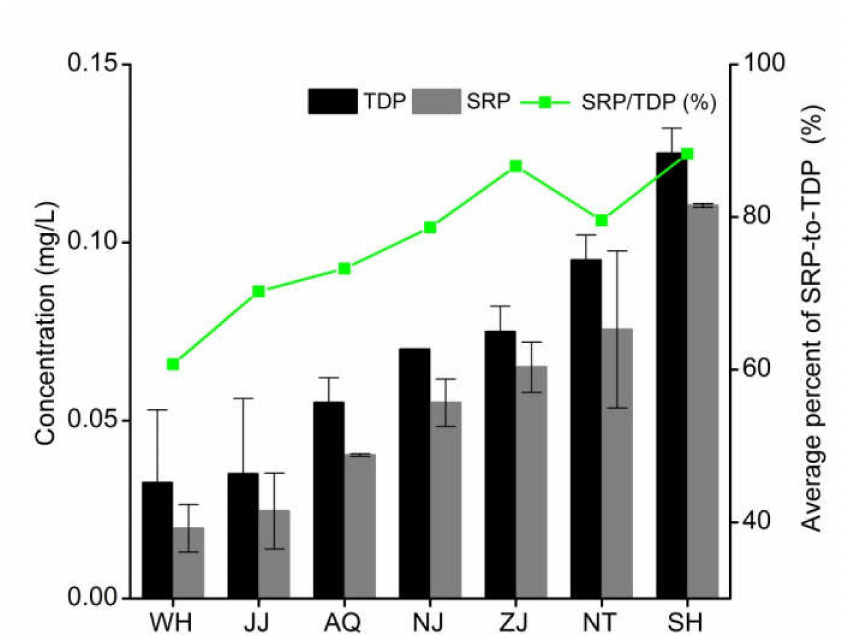
Figure 4. Distribution of total dissolved phosphorus (TDP), soluble reactive phosphate (SRP), and SRP to TDP (%) of water samples in the main urban river stretches along the middle and lower reaches of the Yangtze